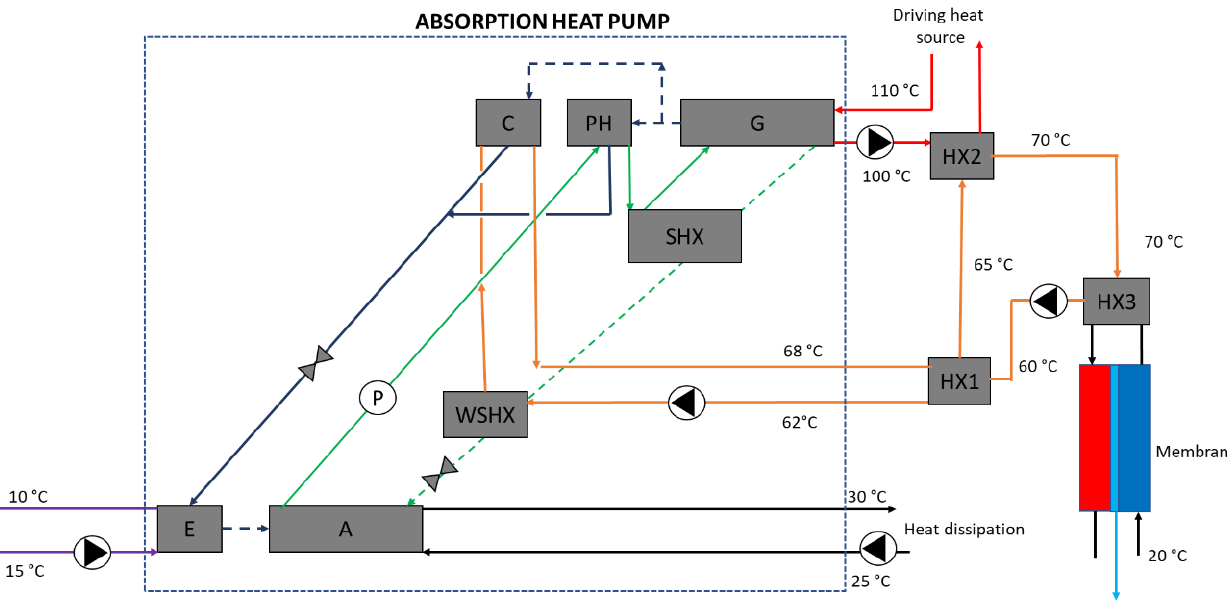
Figure 10. Layout for hybrid air conditioning system with an absorption heat pump and a desiccant evaporative cooling system.